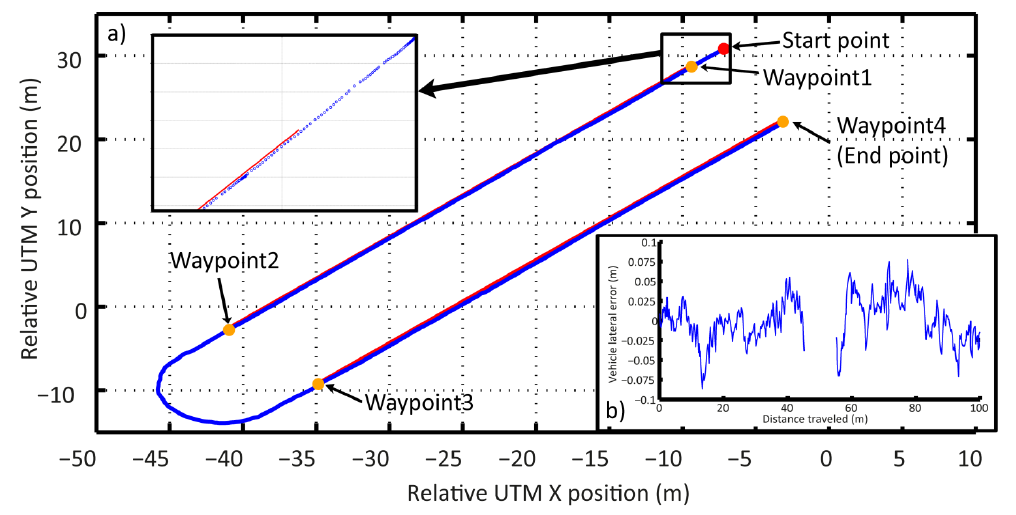
Figure 23. ( a ) The path of the vehicle recorded following the pre-defined mission; ( b ) Error between the trajectory followed by the vehicle and an estimation of the position of the center line of the central rows for each